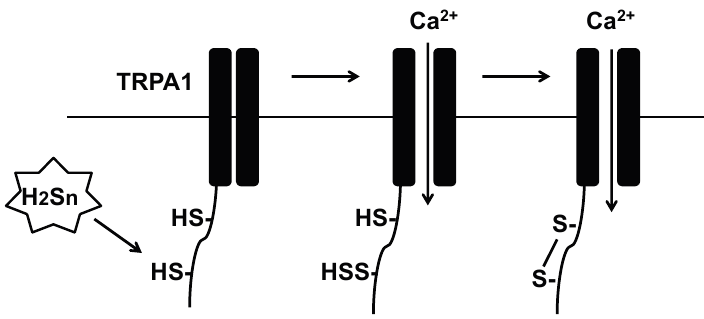
Figure 2. Polysulfides sulfurate cysteine residues of TRPA1 channels to modify their activity. Polysulfides sulfurate Cys422 and Cys622 at the amino-terminus of transient receptor potential ankyrin 1 (TRPA1) channels to activate them.